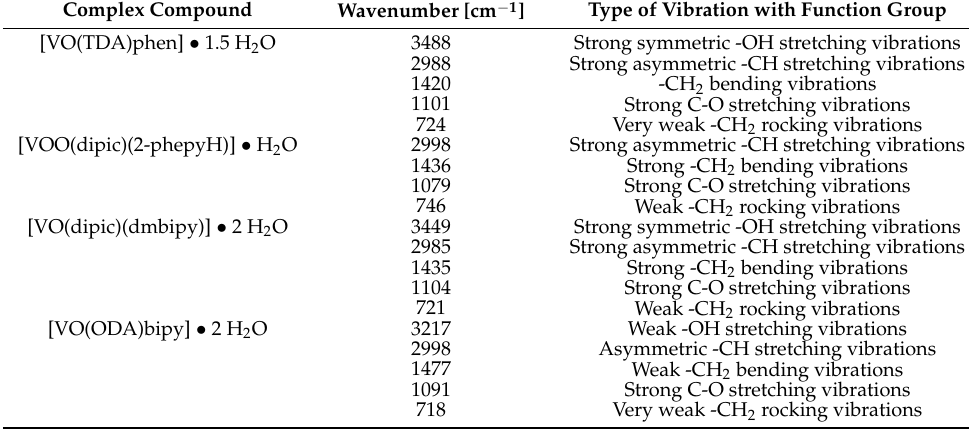
Table 2. The results of FTIR spectroscopy for the products of allyl alcohol oligomerization.